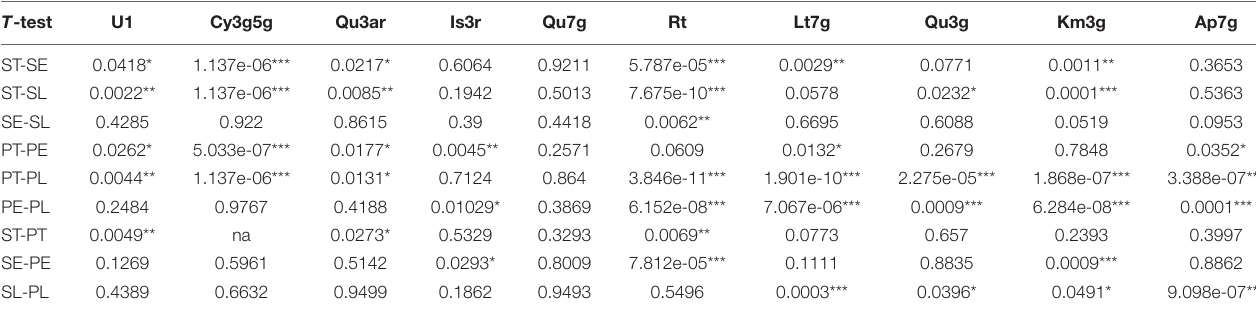
TABLE 4 | The Mann–Whitney U test p -value of flavonoids between different parts of sepal and